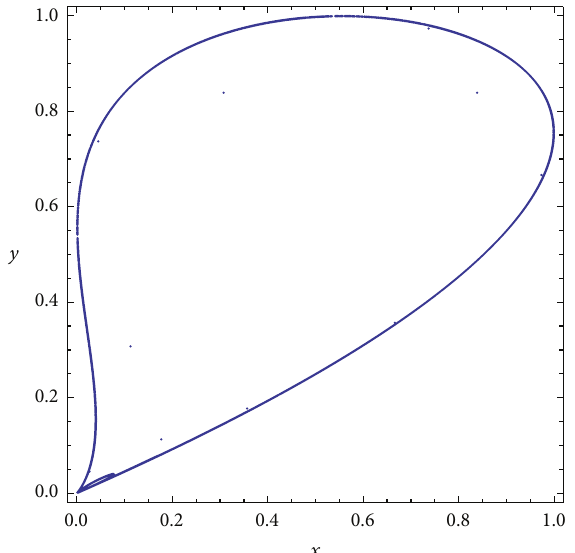
Figure 4: 𝑥 , 𝑦 plot of the delayed logistic